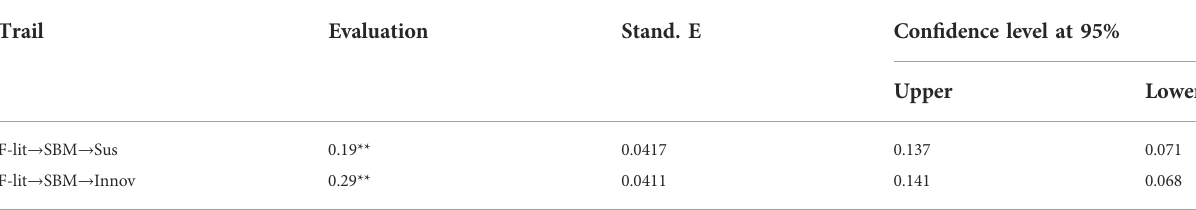
TABLE 5 Indicator impact based on bootstrap